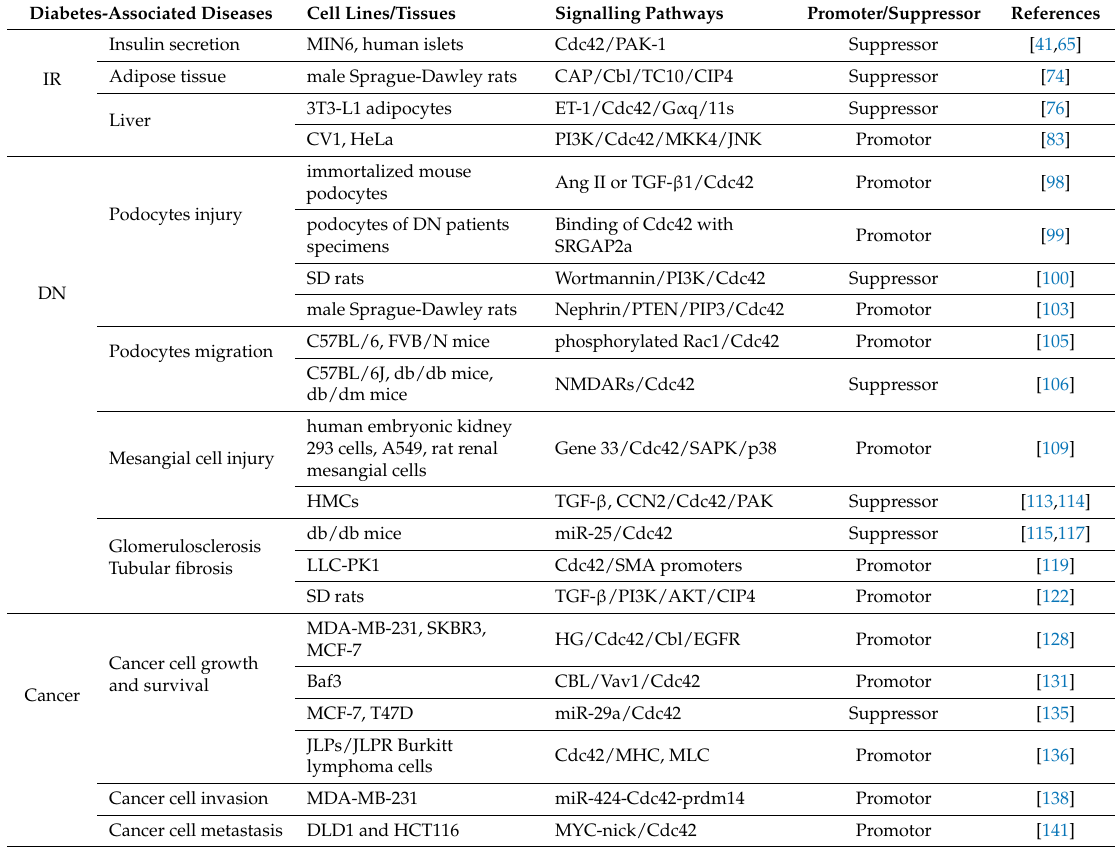
Table 2. Cdc42 and diabetes-associated